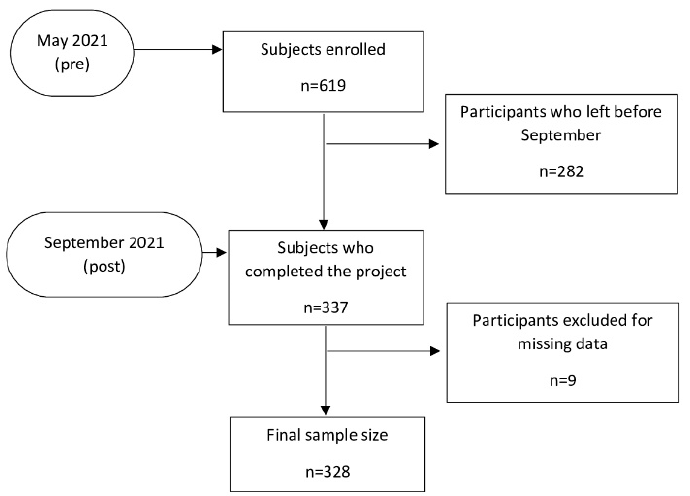
Figure 1. Flow chart of participants.